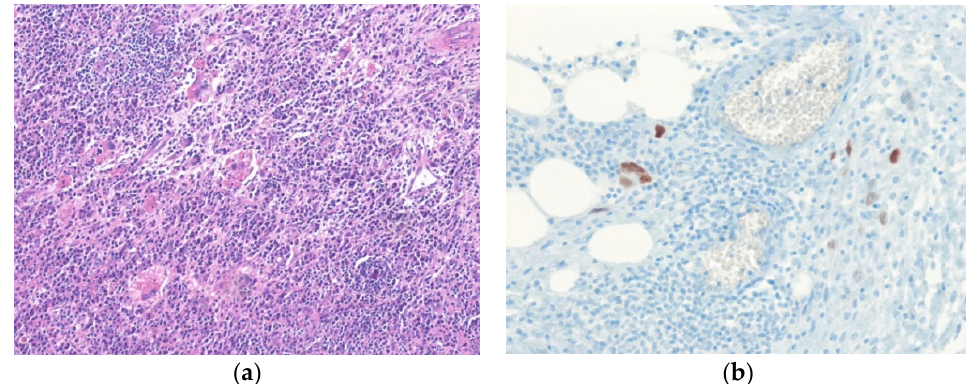
Figure 1. Well-differentiated liposarcoma, inflammatory subtype. ( a ) The tumor shows an abundant chronic inflammatory cell infiltrate and scattered atypical pleomorphic stromal cells. ( b ) The atypical stromal cells are positive for MDM2 (H&E stain, original magnification 100× a ; MDM2 immunostain, original magnification 200× b ).